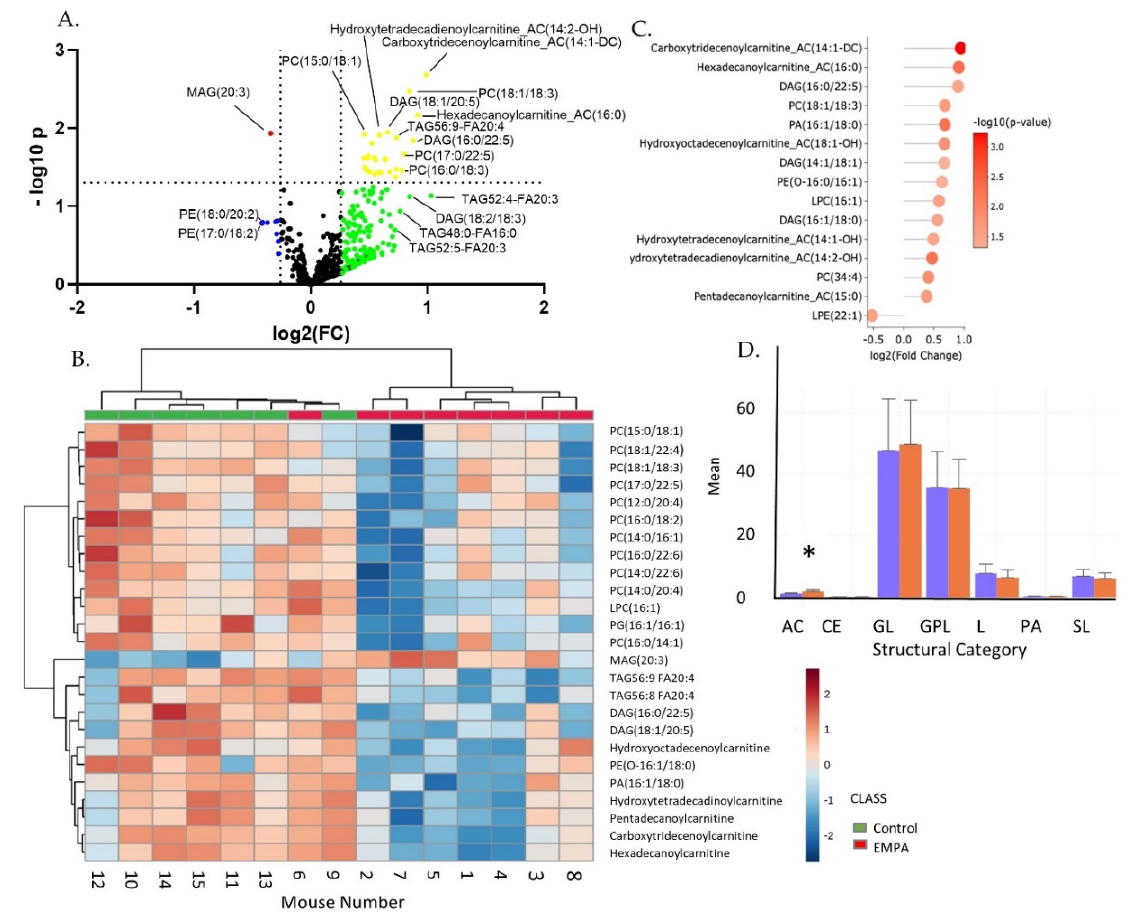
Figure 7. Targeted lipidomics reveals a number of up-regulated species. ( A ) Volcano plot; ( B ) hierarchical clustering (top 25) of metabolites (by p -value); key shows relative levels of metabolites (log2 fold change); ( C ) highly-regulated species; ( D ) structural features. Acyl carnitines (AC), as a structural category, were up-regulated (* p < 0.05, by unpaired t